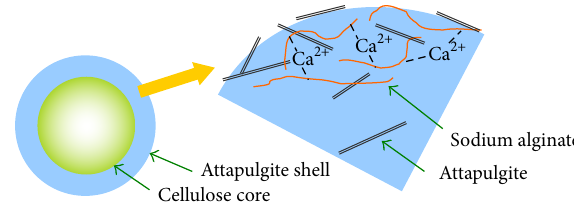
Figure 1: Schematic depiction of core-shell structure of cellulose- attapulgite composite